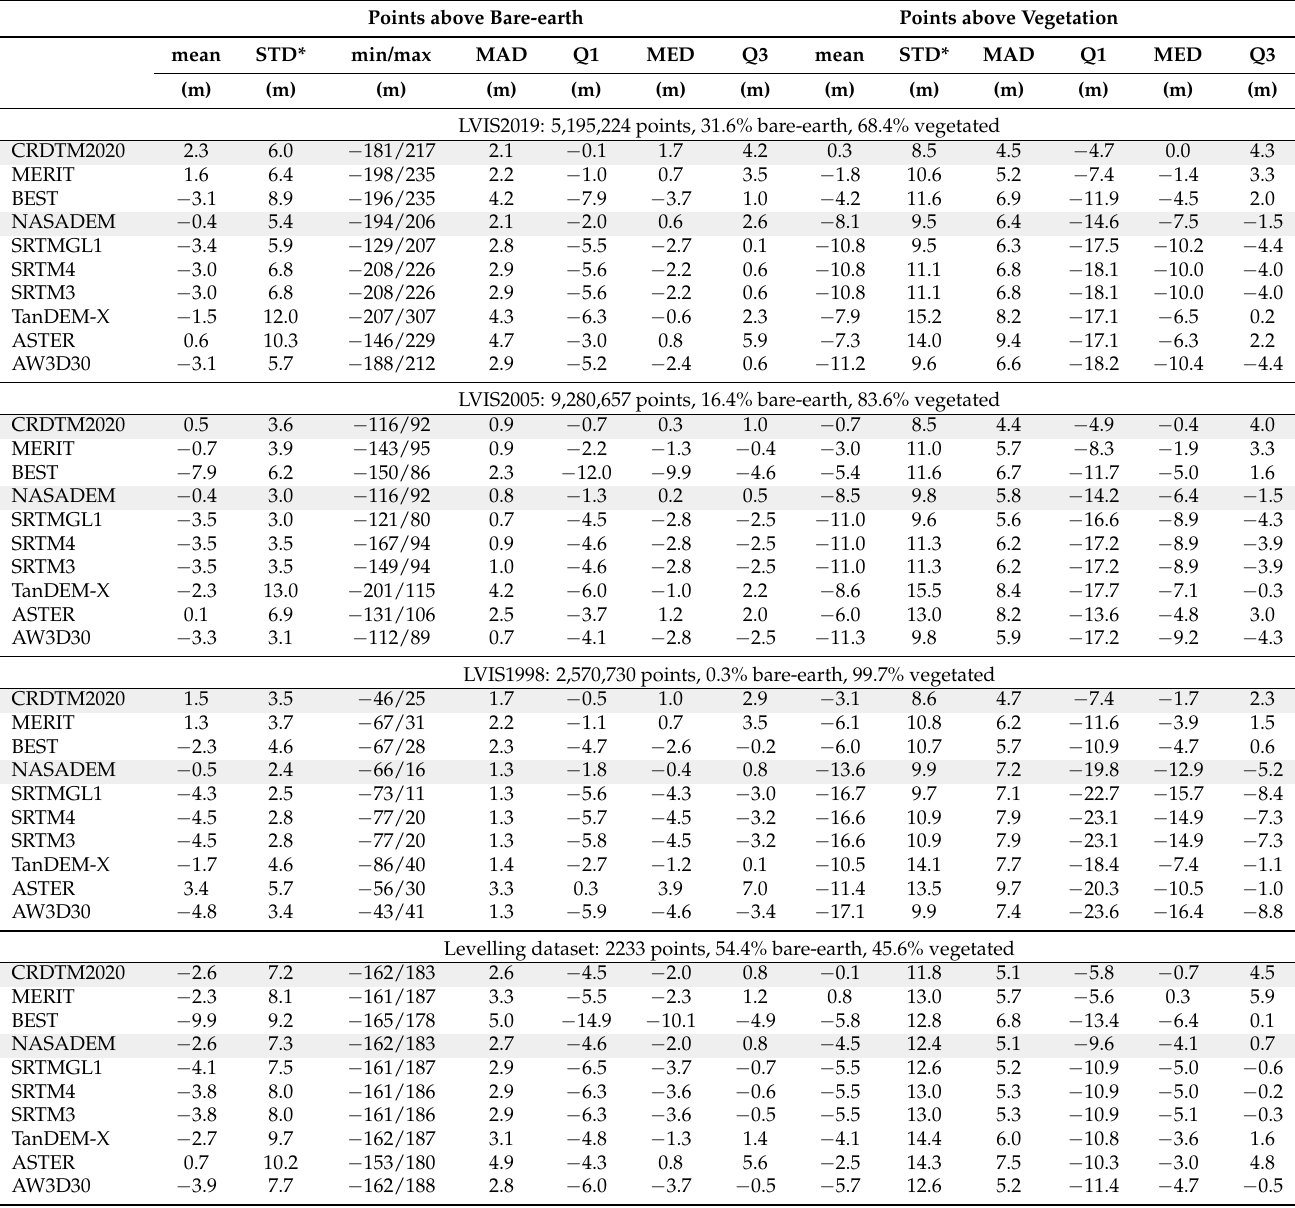
Table 5. Statistics of the differences between LVIS lowest heights (ZG) and the heights of the nine DEMs interpolated on the same locations. Comparison with TanDEM-X was performed directly in terms of ellipsoidal heights, others as heights above the EGM96 geoid. The statistics is provided in terms of the mean difference, Standard Deviation (STD*) for differences without outliers larger than ± 50m, minimum and maximum differences (min/max), Median Absolute Difference (MAD), 25th empirical quartile Q1, the Median (MED) or the 50th empirical quartile Q2, and 75th empirical quartile Q3. Points above Bare-earth Points above